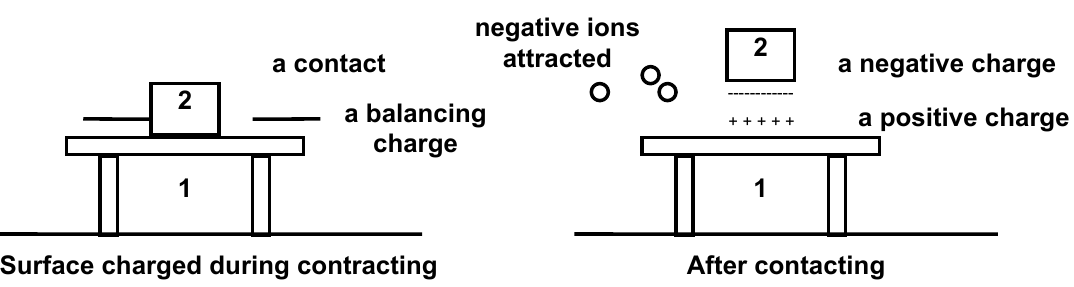
Figure 6: Electric charge surfaces of two building